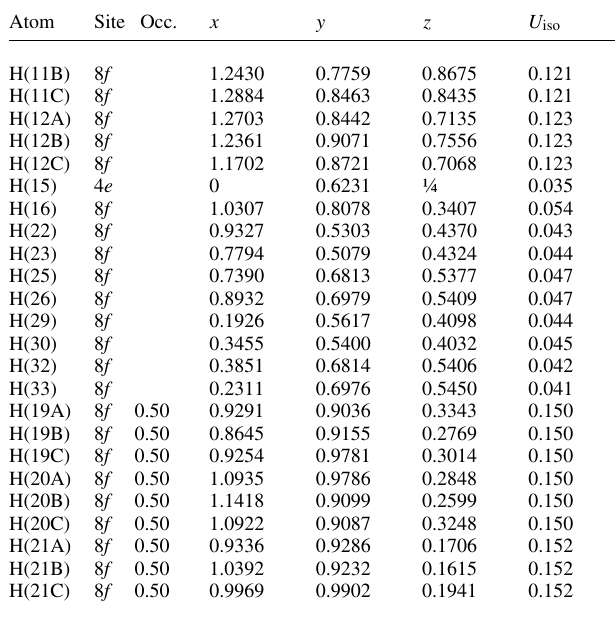
Table 1. Data collection and